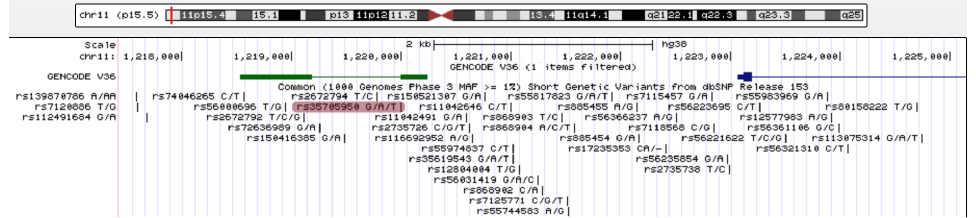
Figure 2. UCSC genome browser Genomic location of the annotated lncRNA AC061979.1. The puta- tive pancRNA AC061979.1 is located on chromosome 11, at 1,218,530–1,220,242—green; the transcrip- tion start site of MUC5B—dark blue; thick line—exons; thin line—introns; rs35705950—highlighted in